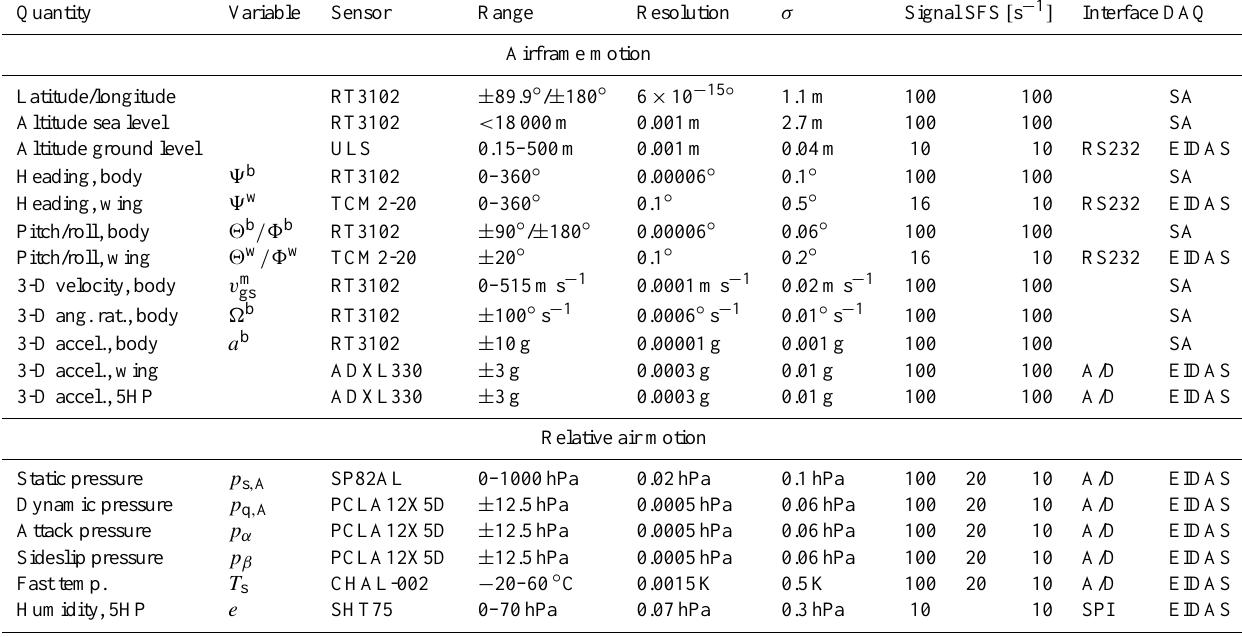
Table 2. List of measured variables, sensor characteristics, signal processing and data acquisition. Individual sensor locations are described in Sect. 2.2 and displayed in Figs. 1 and 3. Resolution refers to the smallest change registered by the data acquisition (DAQ) units. σ is the overall sensor uncertainty provided by the manufacturer in form of one standard deviation. Signal rates are displayed for sampling, filtering and storing (Signal SFS). Data acquisition takes place in two forms, standalone (SA) and on the central DAQ unit EIDAS. For non SA devices signal forwarding via A/D converter, recommended standard 232 (RS232) or serial peripheral interface (SPI) is indicated (Interface